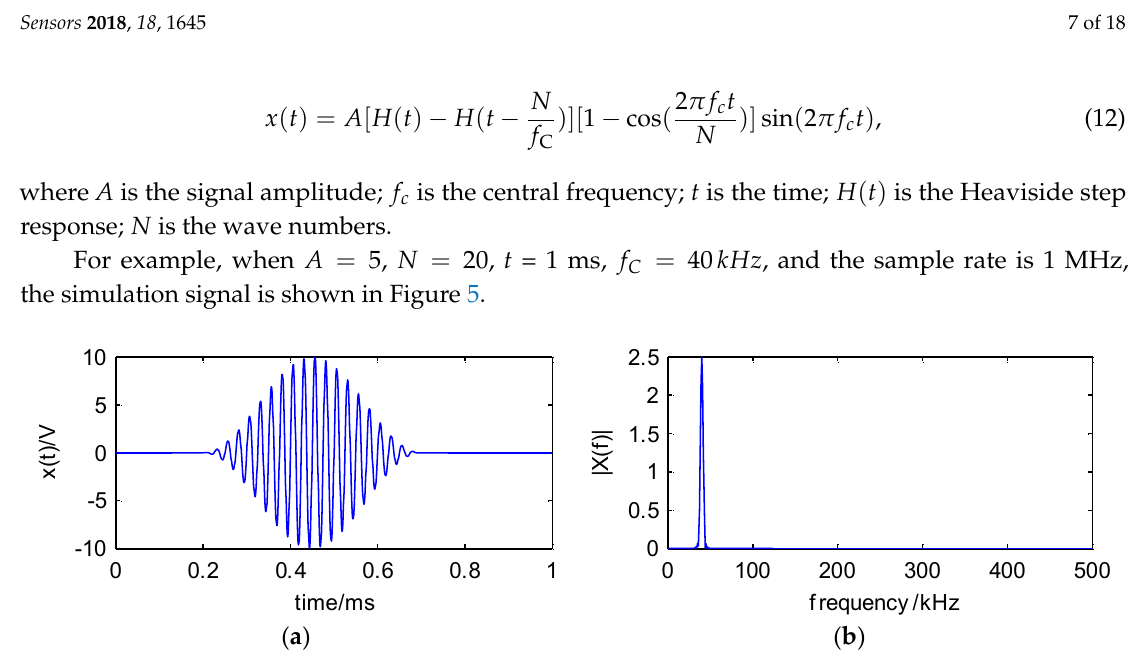
Figure 5. The ( a ) waveform and ( b ) spectrum of the simulation signal.